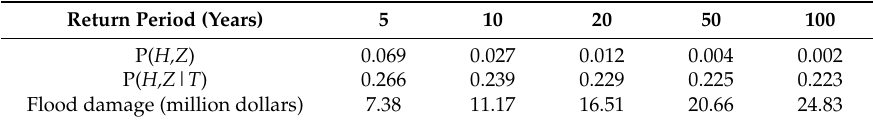
Table 11. P( H,Z ), P( H,Z|T ), and flood